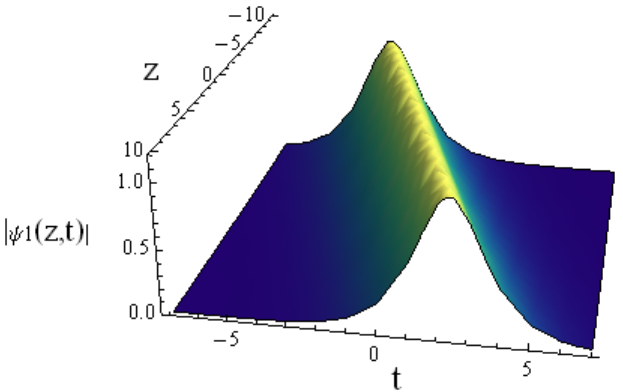
Figure 4. Change of solution (14) with z , t for c = 0.5, v = 0.7, β 1 = 0.1, β 2 = 1, β 1 = 0.1, β 3 = 0.3, β 4 =